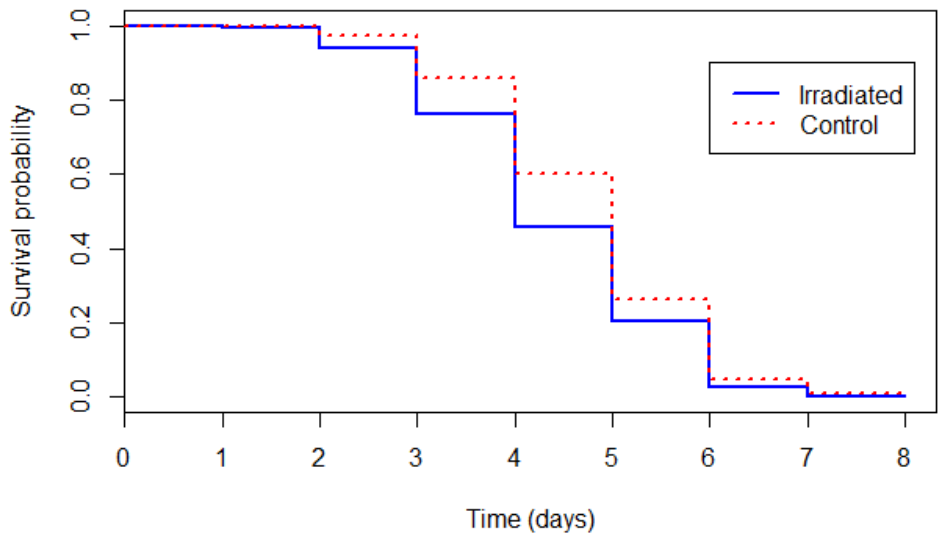
Figure 1. Survival curves of the control and irradiated male tsetse flies under starvation stress conditions.